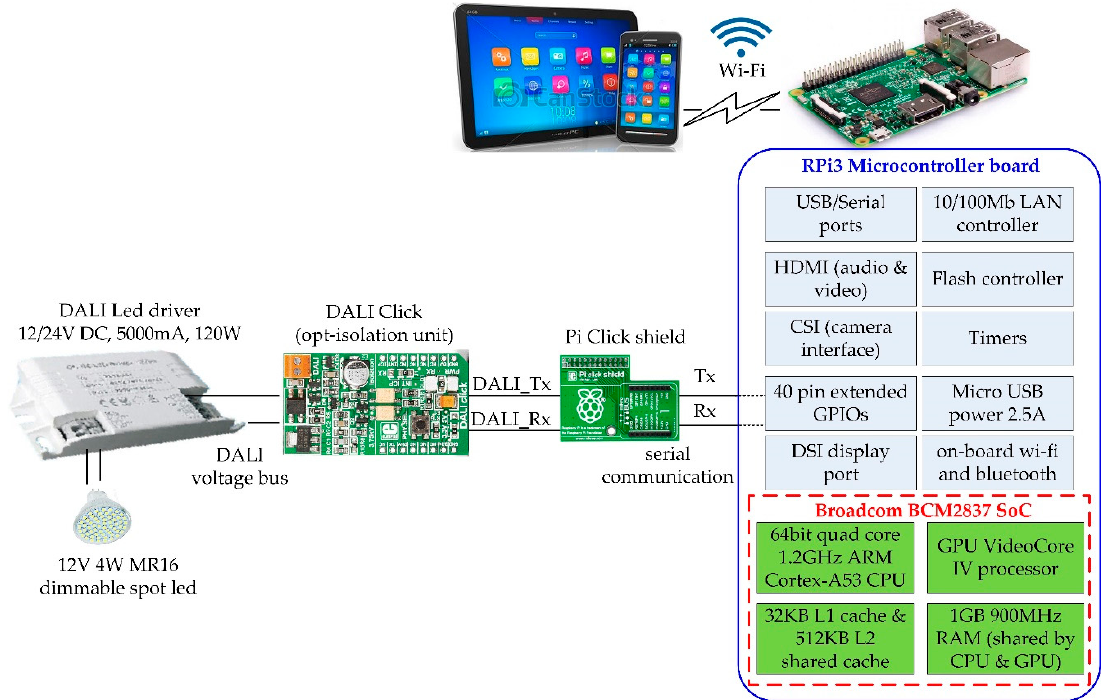
Figure 2. Raspberry Pi3 Model B (RPi3)-based DALI controller block diagram.